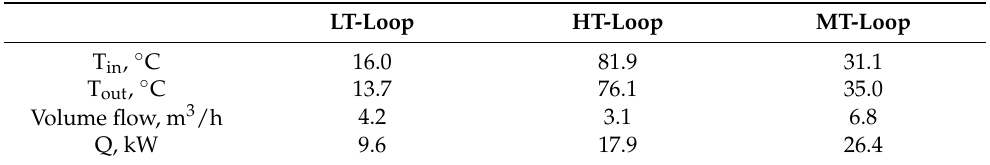
Table 1. Testing conditions of a reference ad/desorption